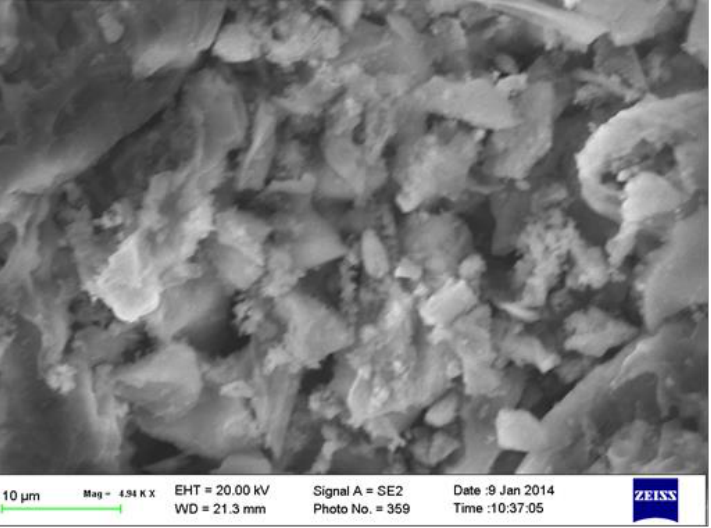
Figure 3. Microstructure of additives based on synthetic aluminosilicates ×20,000.